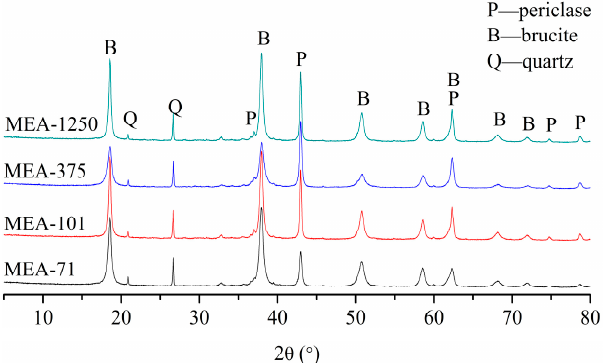
Figure 6. XRD patterns of compacted MEAs cured in water at 40 ◦ C when the expansion stresses